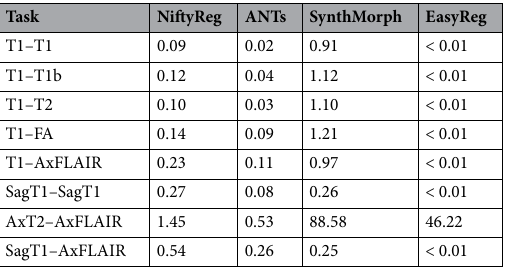
Table 1. Number of voxels with negative Jacobian determinants, for the different methods and registration tasks. Only voxels inside the brain are considered.